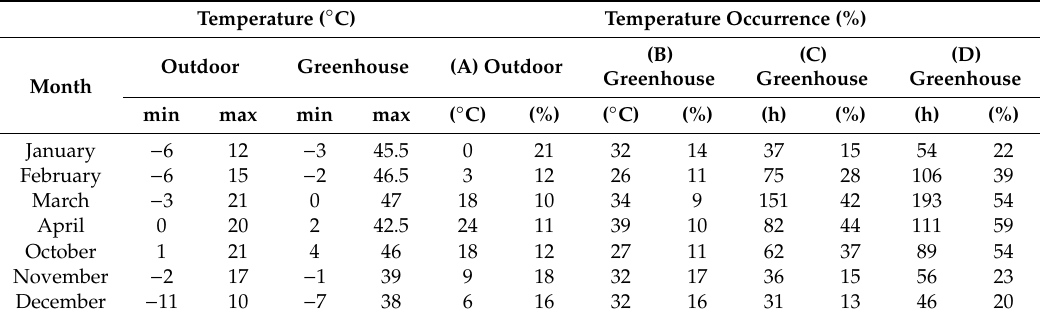
Table 7. Analysis of the contribution of the greenhouse during the heating season.